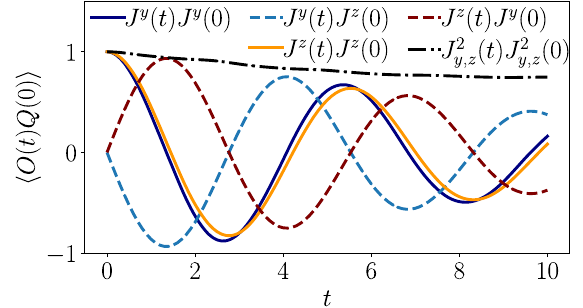
FIG. 10. Time evolution of the various global spin operators projected to the constrained space. In particular, h J 2 y;z ð t Þ J 2 y;z ð 0 Þi remains close to 1, indicating an approximate conservation